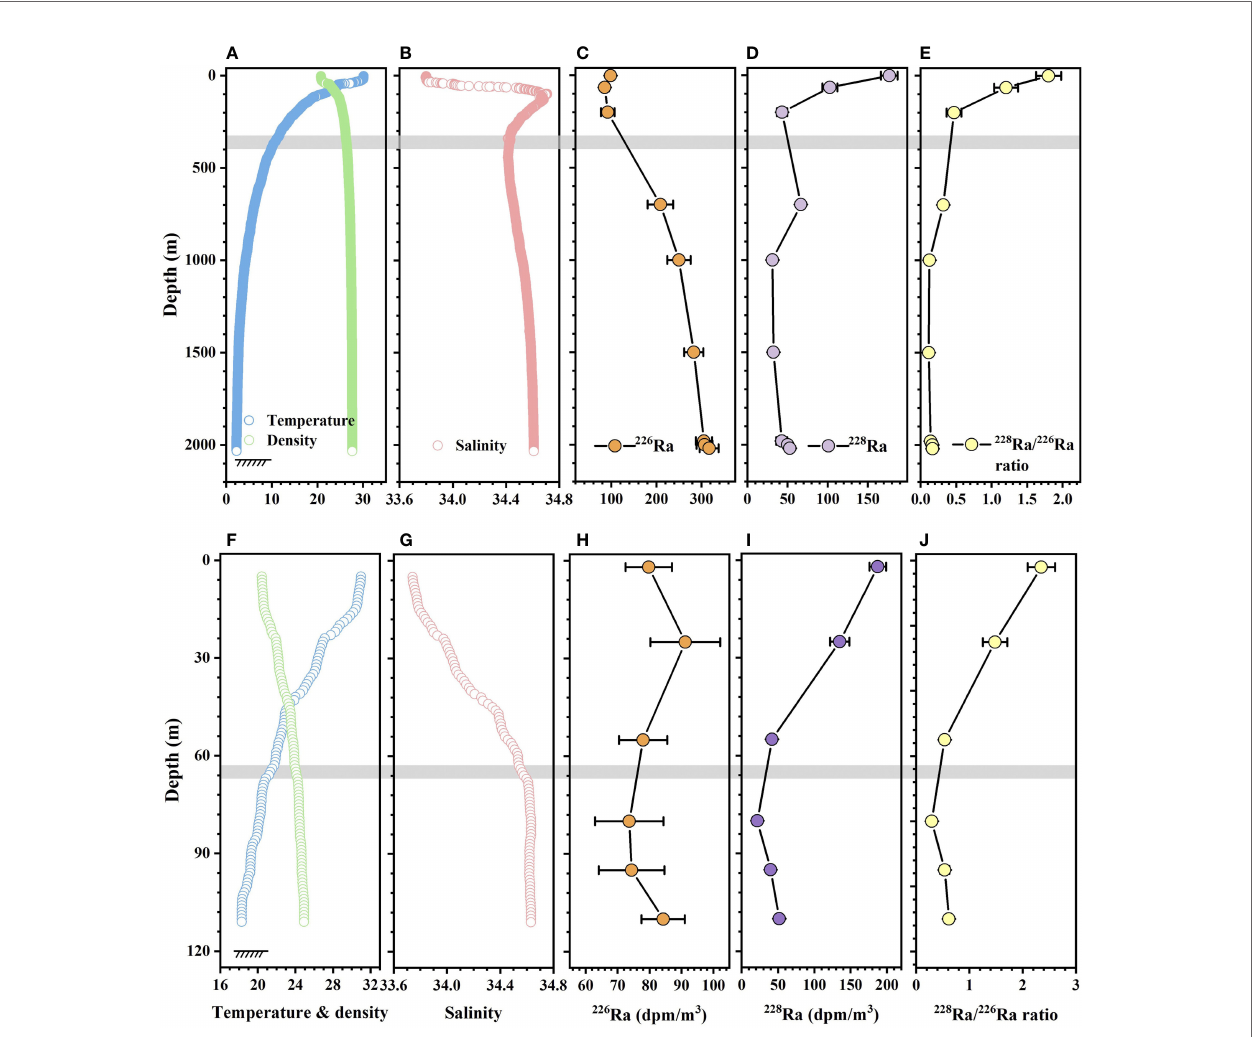
FIGURE 5 | Depth pro fi les of temperature (°C), density (kg/m 3 ), salinity, 226 Ra, 228 Ra activities (dpm/m 3 ) and 226 Ra/ 228 Ra ratios at stations (A – E) J6 and (F – J) J8. The gray bands indicate the boundary of the different layers, highlighted by the signi fi cant changing salinity and Ra